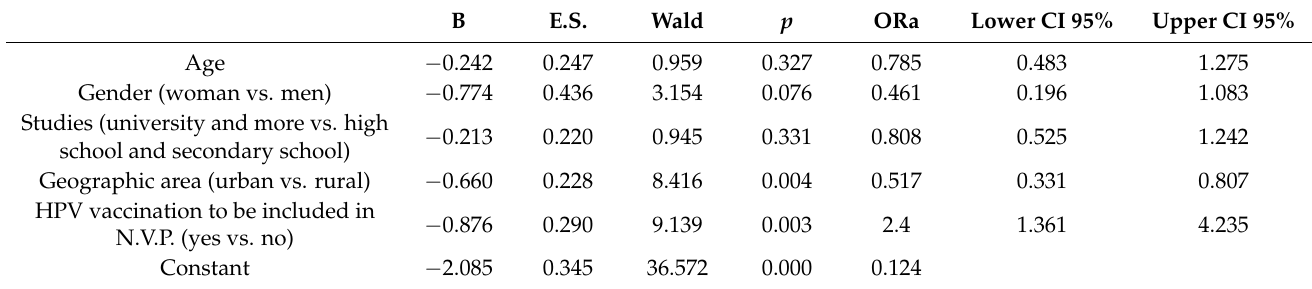
Table 6. Logistic regression model for the 118 HPV-vaccinated responders of our